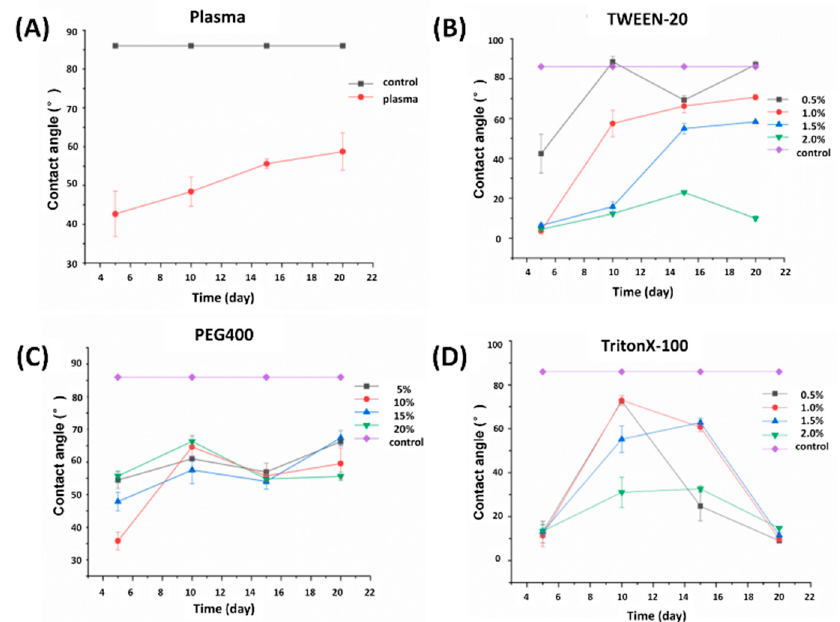
Figure 5. Contact angle results: ( A ) oxygen plasma; ( B ) Tween-20; ( C ) PEG400; ( D ) TritonX-100. The contact angles of the four hydrophilic methods are small in a short time after treatment, and the average contact angle on the fifth day of oxygen plasma treatment group is 42.64 ◦ (Figure 5A). The average contact angles of Tween-20 treatment group (0.5% v / v , 1.0% v / v , 1.5% v / v and 2.0% v / v ) on the fifth day are 42.34°, 3.59°, 6.45° and 4.46°,